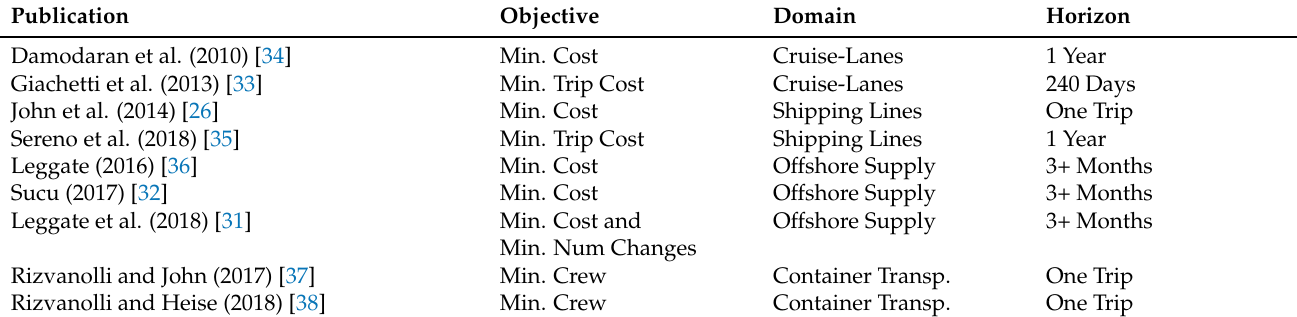
Table 2. Articles proposing models with similar problems by domain and year of